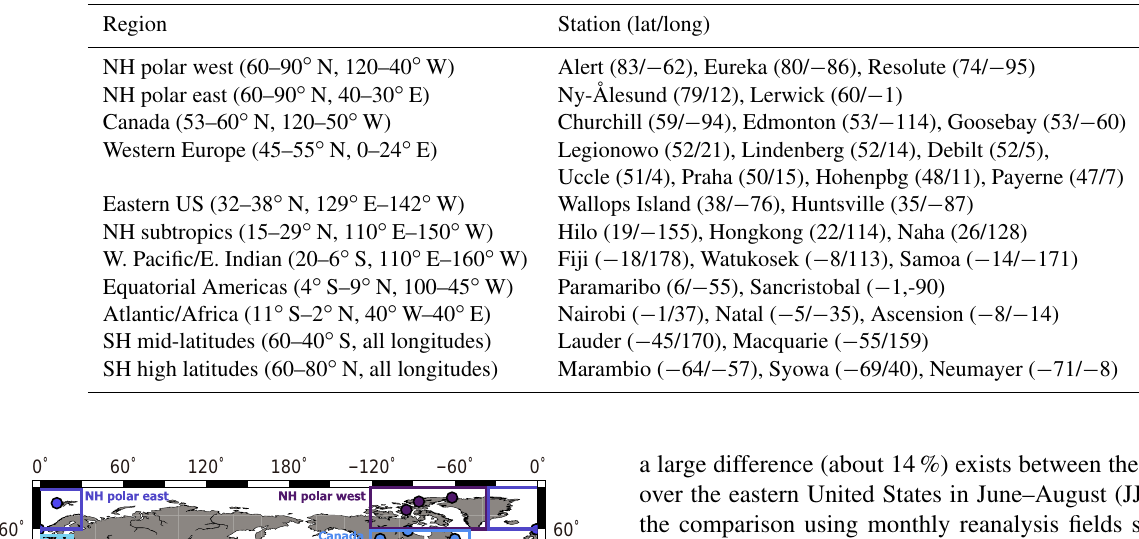
Table 6. Regions and observation sites used in model evaluation in Sect. 5. The 11 regions are defined following Tilmes et al. (2012). See also Fig. 8.